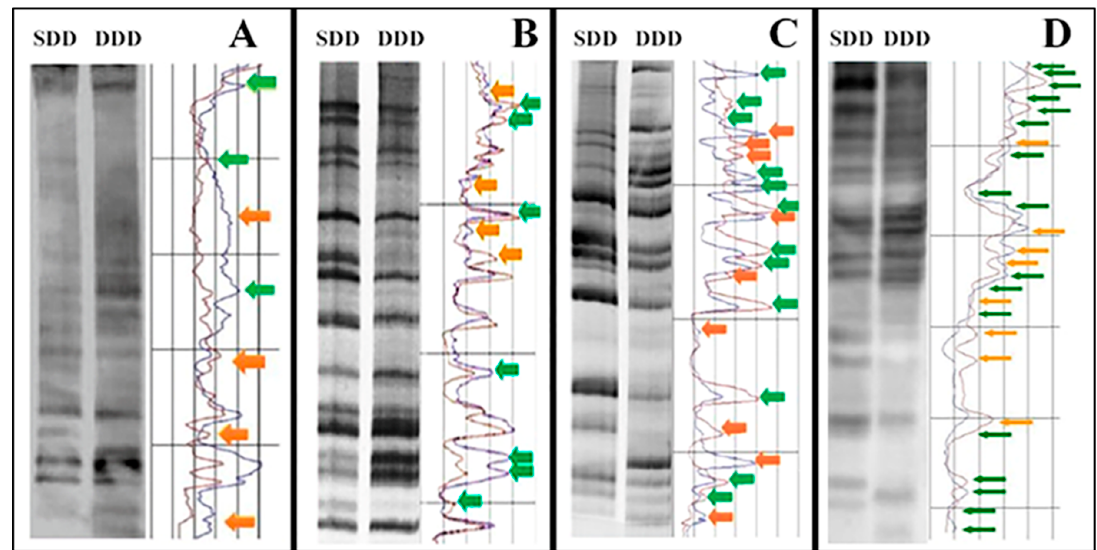
Figure 5. MeSAP DNA ‐ Fingerprinting and relative densitometer scanning of primary astrocytes ( A ) and clones ( B – D ). The yellow arrows indicate appearing/disappearing and the green ones indicate attenuation/intensification of bands. By analyzing band pattern differences between single ‐ digested DNA (SDD) and double ‐ digested DNA (DDD) it is possible to evidence 7 variations in primary astrocytes ( A ), 11 in A ‐ GS1( B ), 21 in A ‐ VV5 ( C ) and 25 in A ‐ FC6 ( D ).